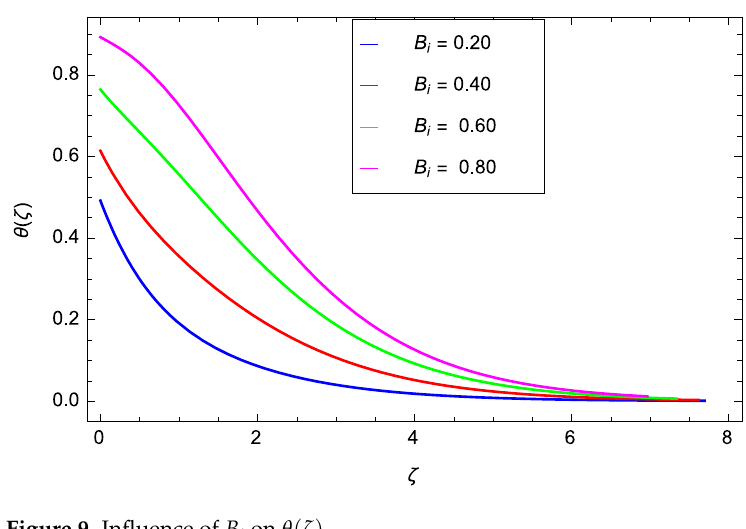
Figure 9. Influence of B i on θ ( ζ ) .